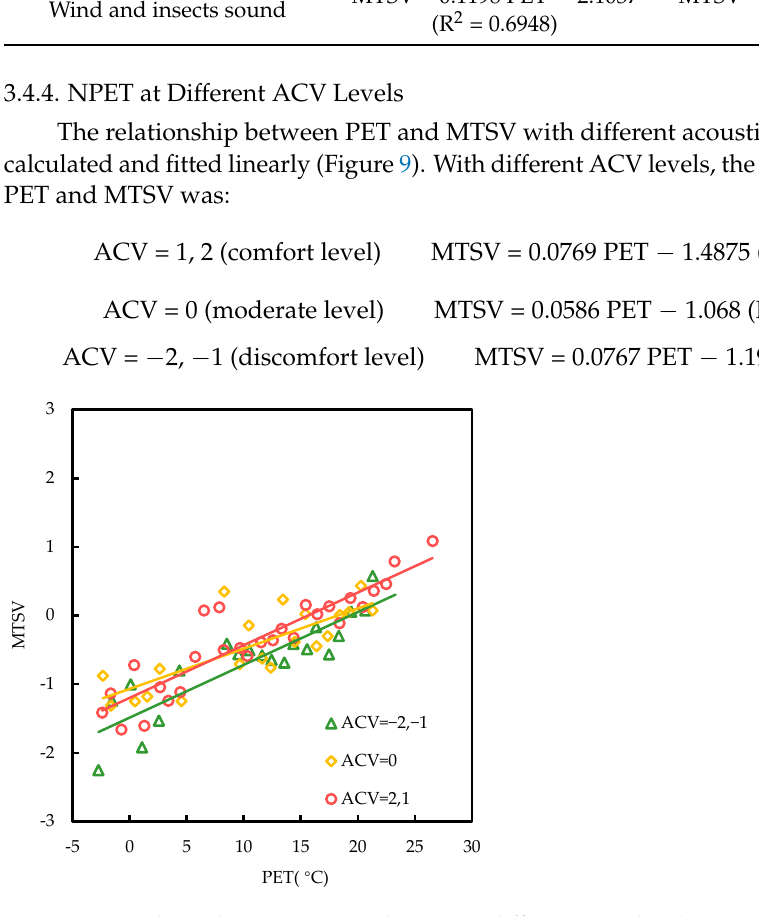
Figure 9. Correlation between PET and MTSV at different ACV levels.